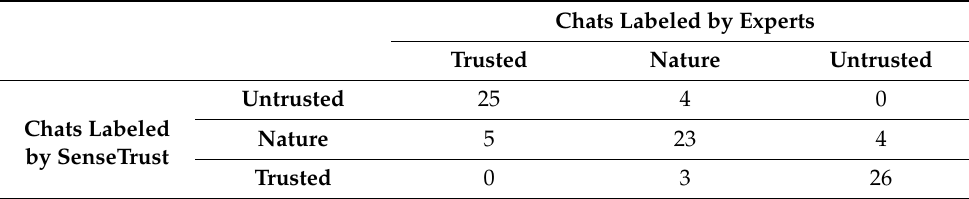
Table 5. Experimental Results.